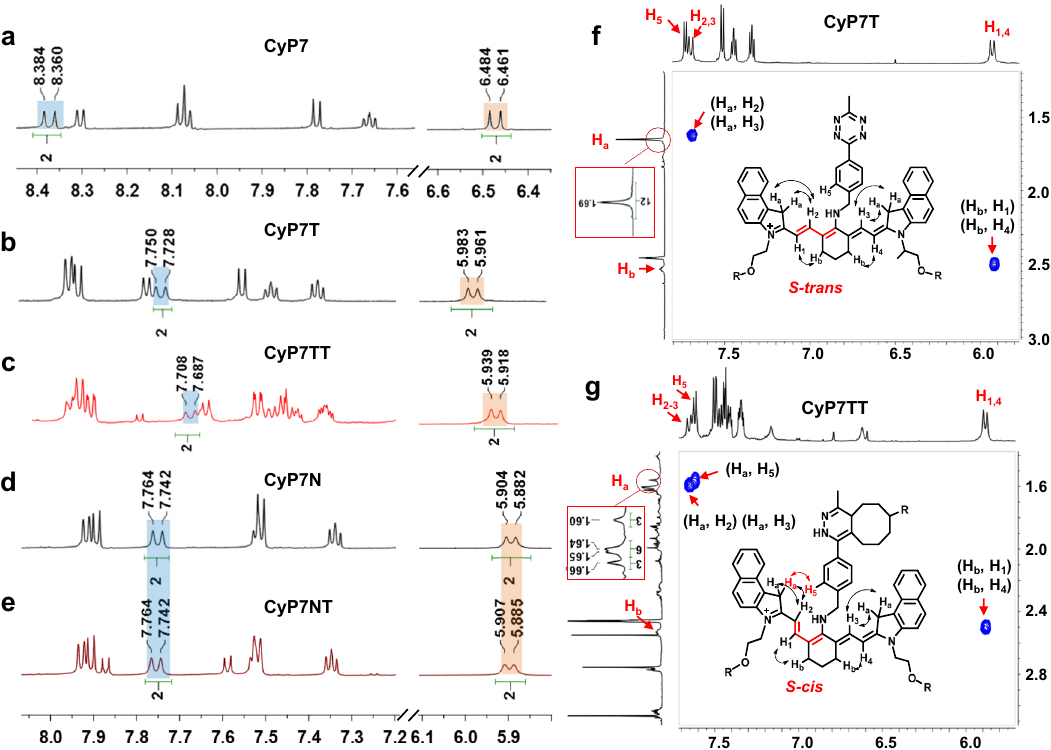
Fig. 4 1 H and 2 D ROESY NMR analysis. 1 H NMR shift changes of vinyl-hydrogens (H 1 , H 2 , H 3 , H 4 ) for a CyP7, b CyP7T, c CyP7TT, d CyP7N, and e CyP7NT. Orange regions refer to H 1 /H 4 and blue regions refer to H 2 /H 3 . 2D ROESY NMR of f CyP7T and g CyP7TT in DMSO- d 6